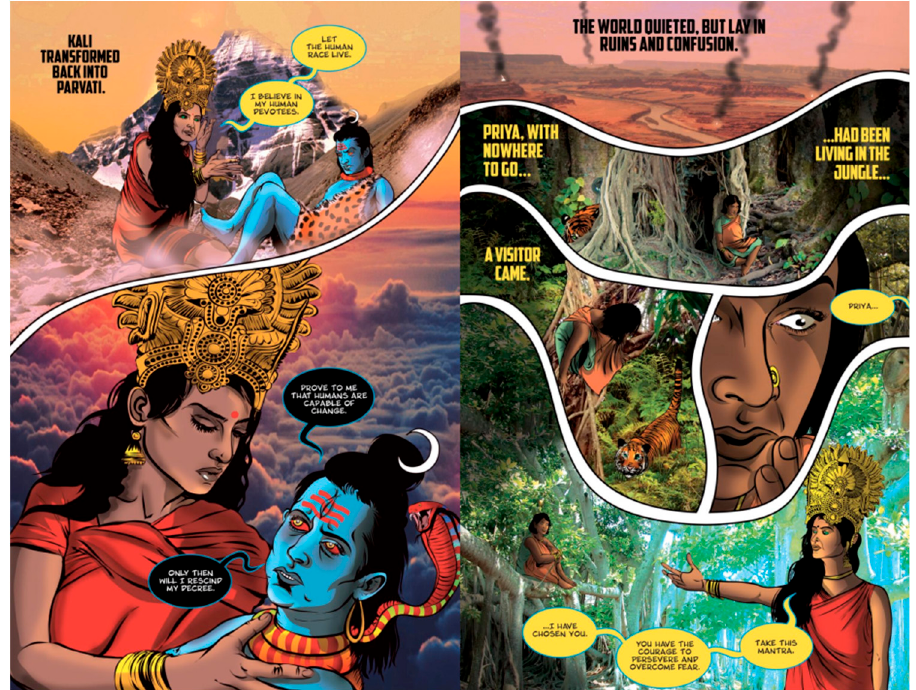
Figure 6. Parvati reaches out to a frightened Priya. Image Courtesy: Ram Devineni.